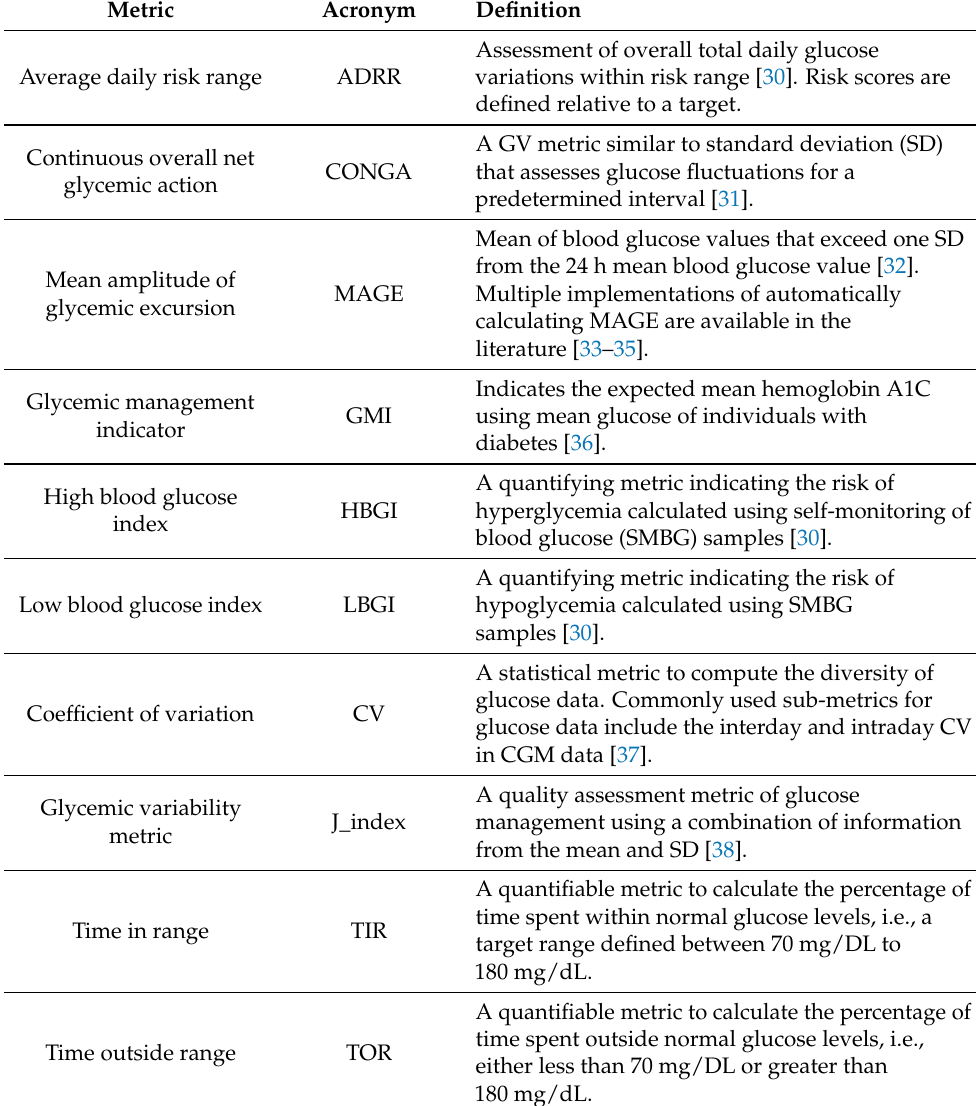
Table 1. Clinically Validated Glucose Variability